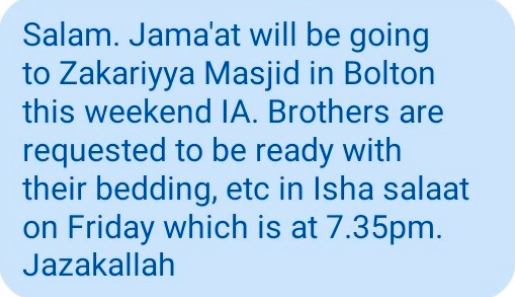
Figure 11. An example of a text message sent out on Wednesday informing potential participants about the coming weekend’s jama’at . Source: author’s mobile phone.